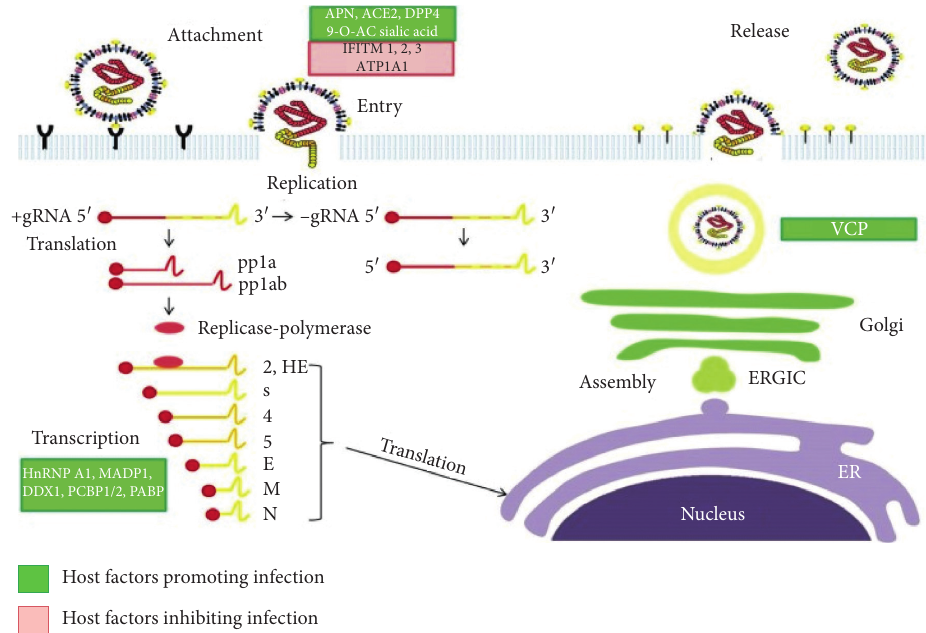
Figure 1: Schematic representation of coronavirus replication cycle (image from Xinyi et al., Diseases 4 (3) (2016): 26; https://www.ncbi.